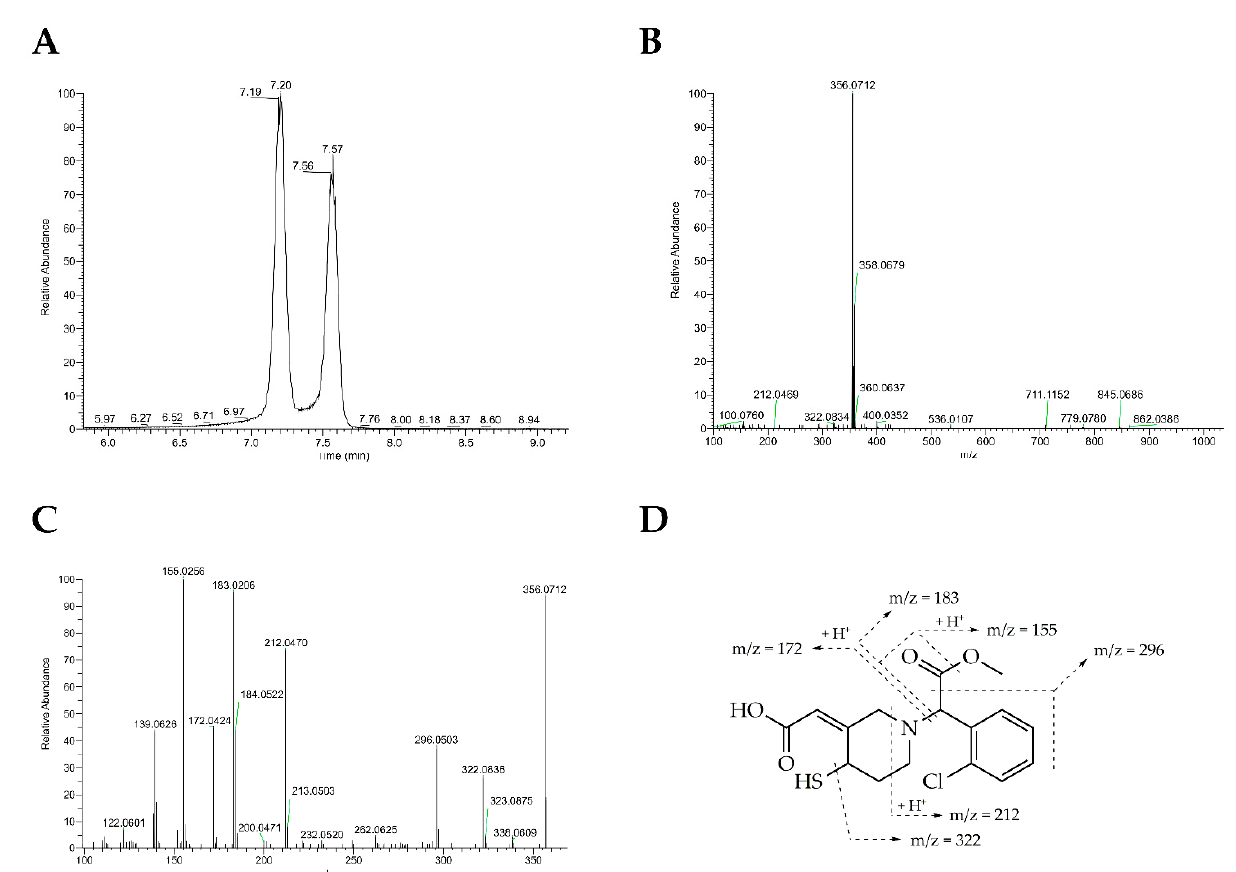
Figure 2. Extracted ion chromatogram and MS and MS 2 spectra of isomers of active clopidogrel metabolite (CAM) formed during conversion of 1 mM clopidogrel by 2 U mL − 1 Mro UPO in presence of 5 mM ascorbate, 20 mM KP i buffer (pH 7.0) and in sum 4 mM hydrogen peroxide. ( A ) Extracted ion chromatogram at m / z 356 (MS); ( B ) MS spectra of the two isomers; ( C ) MS 2 spectra of the ion at m / z 356 with collision energy of CE20; ( D ) assignment for the fragmentation pattern in Figure 2C.